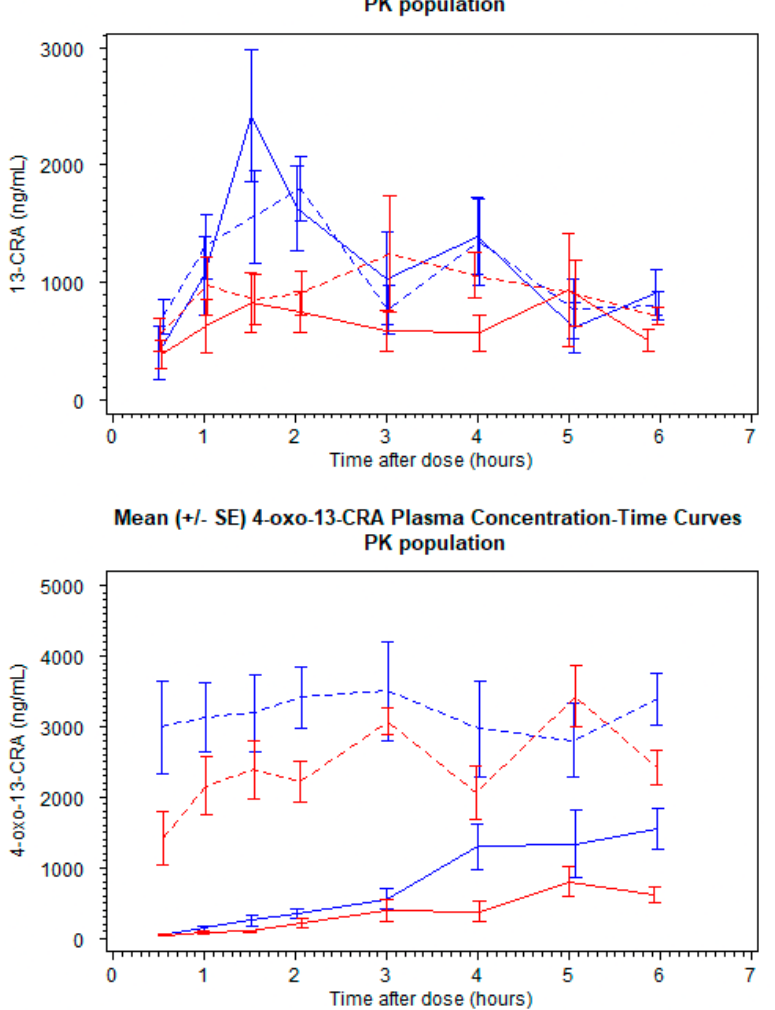
Figure 2. Mean (SE) plasma concentration versus time profiles for 13- cis -retinoic acid (13-CRA) (upper panel) and 4-oxo-13-CRA (lower panel). Blue lines are oral liquid, red lines are extracted capsule. Continuous lines are Day 1, interrupted lines are Day 14.